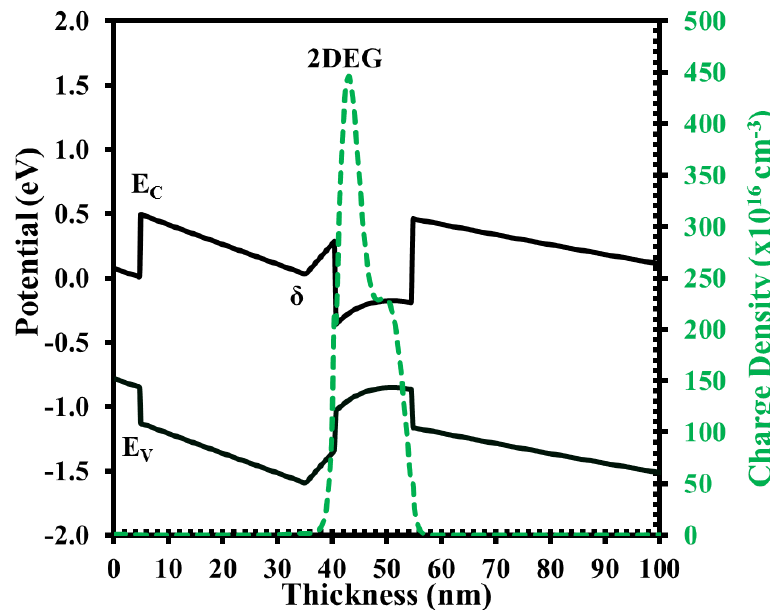
Figure 3. XMBE171 conduction band diagram and electron